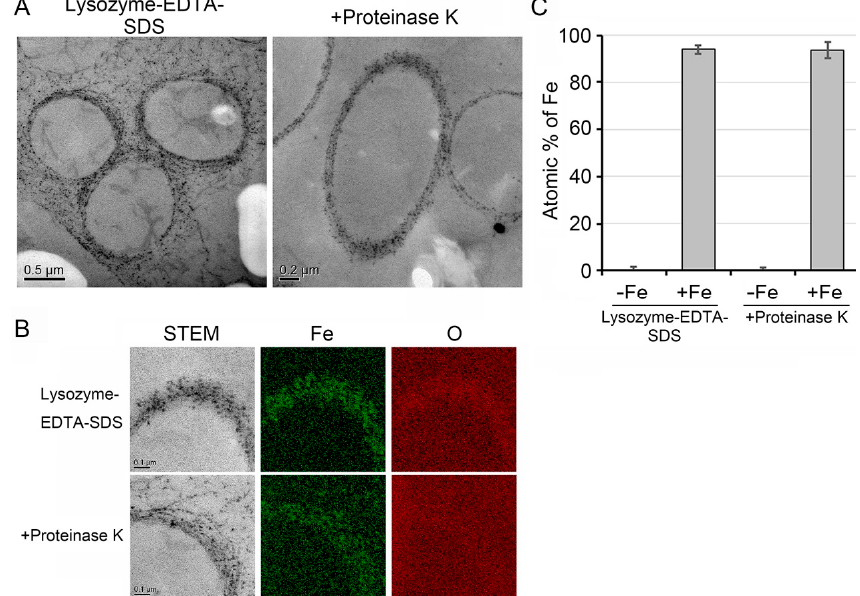
Figure 7. Adherence of Fe particles onto both LES- and LES/ProK-treated sheath remnants. ( A ) STEM images of cross-sectioned LES- ( left ) and LES/ProtK-treated sheath remnants ( right ) after 14 days incubation in SGP + Fe; ( B ) EDX mapping of LES- ( upper ) and LES/Prot K-treated sheath remnants ( lower ). Note the entire distribution of Fe and O in both sheath remnants, suggesting the presence of Fe oxides. ( C ) Mean (± s.d.) atomic percentage of Fe in LES- and LES/ProK-treated sheath remnants before and after incubation in SGP + Fe. n = 10 spots per sample.